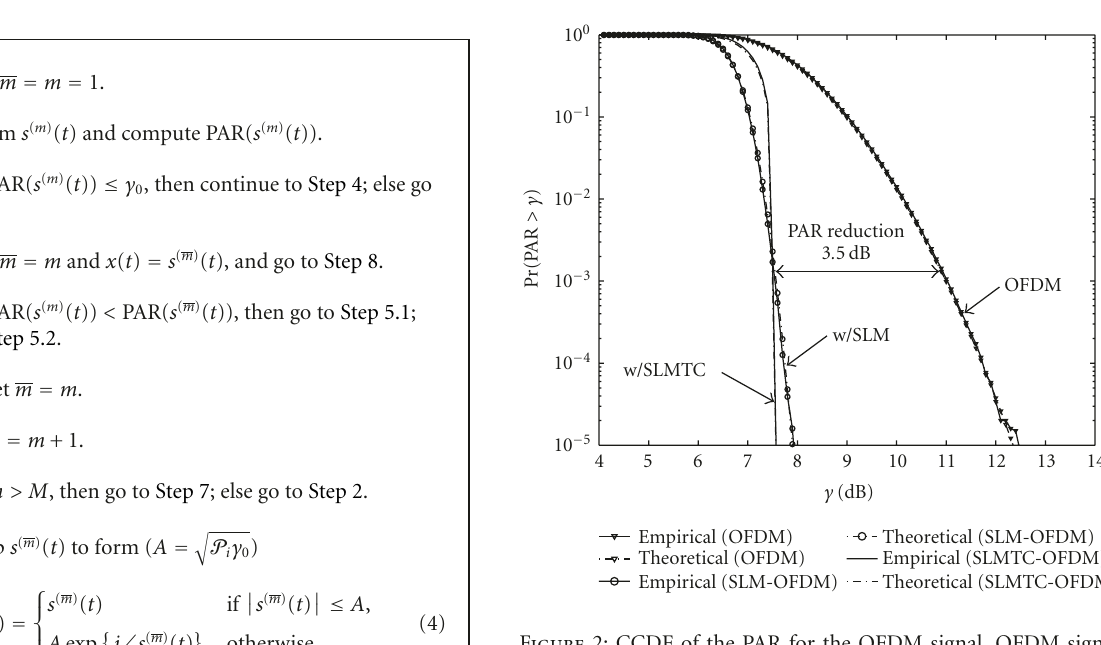
Figure 2: CCDF of the PAR for the OFDM signal, OFDM signal with SLM, and OFDM signal with